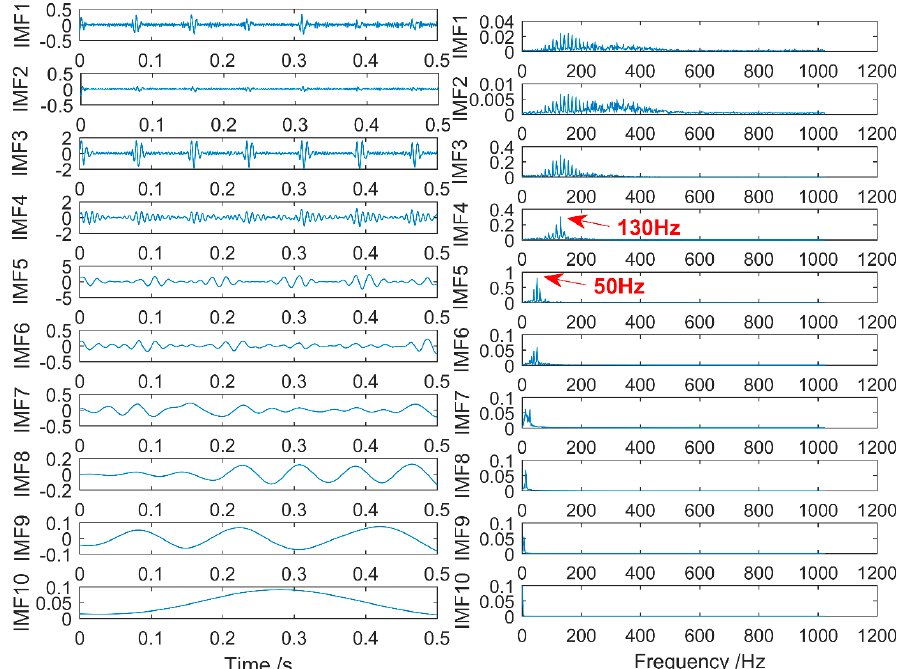
Figure 11. MSE value of the component signal (reconstructed signal is decomposed by CEEMD). 4. Experimental Verification To verify the feasibility of the proposed method in engineering application, it is planned to use the gearbox fault test bench for experiments. The experiment bench is shown in Figure 12, which includes a triple-phase asynchronous motor, connector, gear speed increaser, torque and rotational speed sensor, planetary reducer, triaxial acceleration sensor, and magnetic powder loader. The